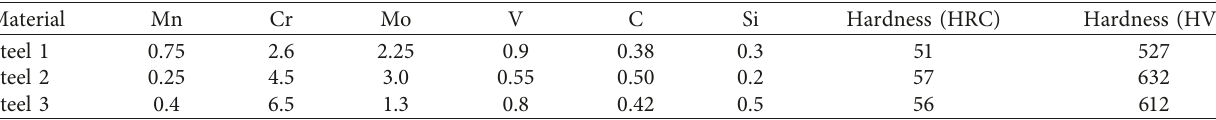
Table 3: Chemical composition (wt.%) and hardness of hot work tool